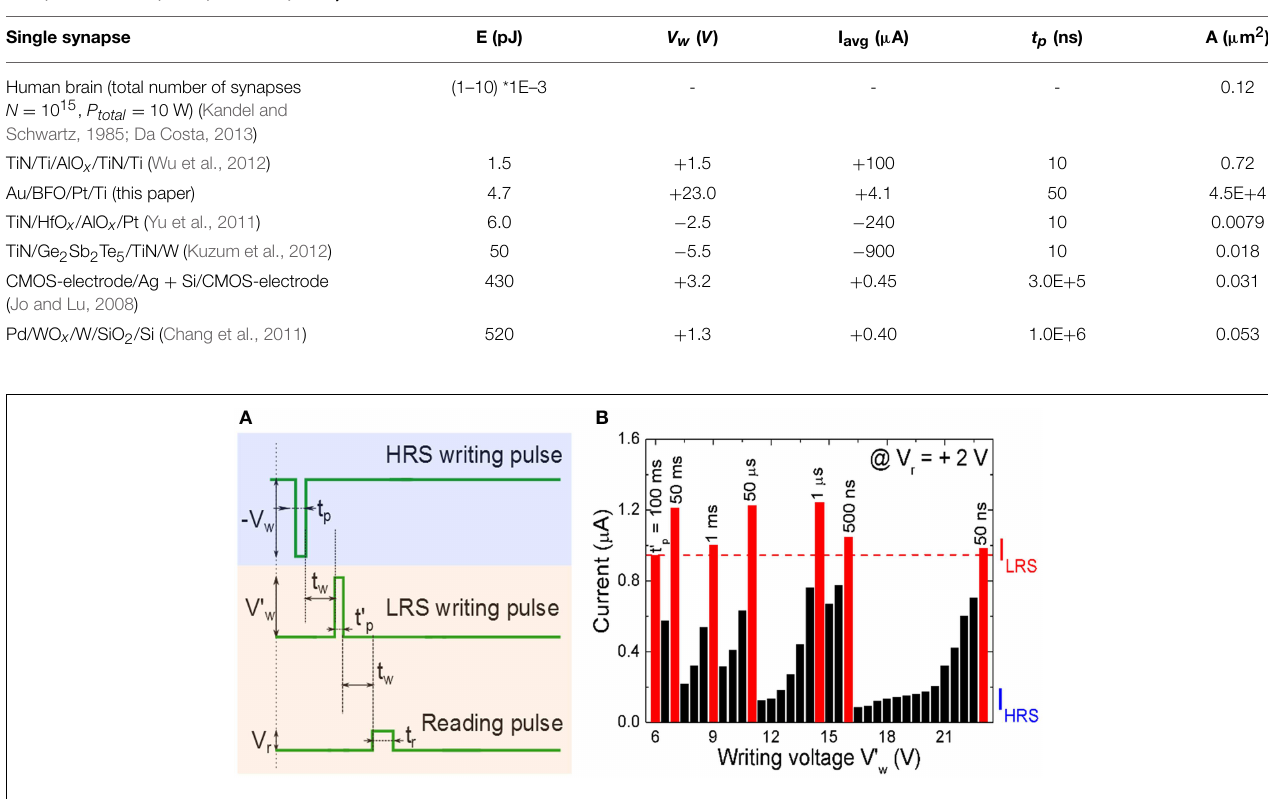
from 6.0 to 23.0V and with different constant pulse widths of t ′ p = 50 ms, 1ms, 50 µ s, 1 µ s, 500ns, and 50ns. The reading voltage amounts to + 2.0V. For a given pulse width at least one writing voltage (red bar) is large enough to set the BFO memristor in the LRS. In that case the reading currents is even larger than the current I LRS read out after applying a writing voltage of V w = + 6 . 0 V with a pulse width of t ′ p = 100 ms (first red